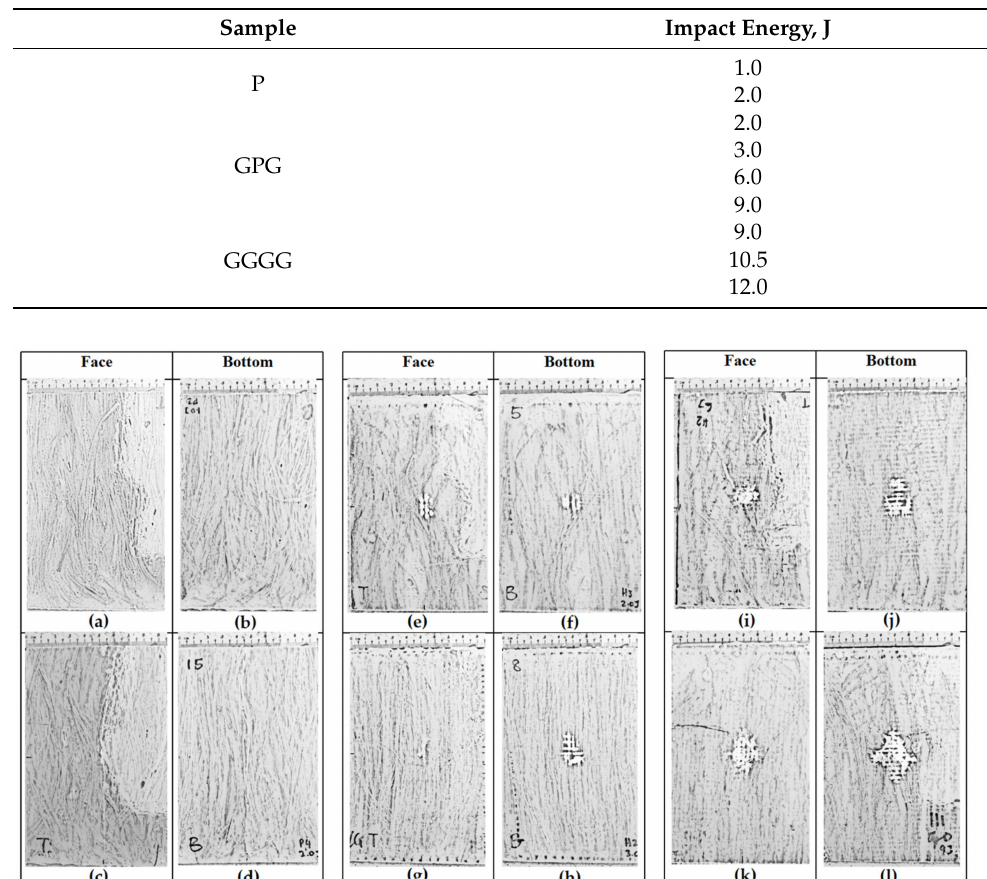
Figure 5. Schematic diagram of the P and GPG impacted samples according to the energy level: ( a ) P 1.0 J, ( b ) P 1.0 J, ( c ) P 2.0 J, ( d ) P 2.0 J, ( e ) GPG 2.0 J, ( f ) GPG 2.0 J, ( g ) GPG 3.0 J, ( h ) GPG 3.0 J, ( i ) GPG